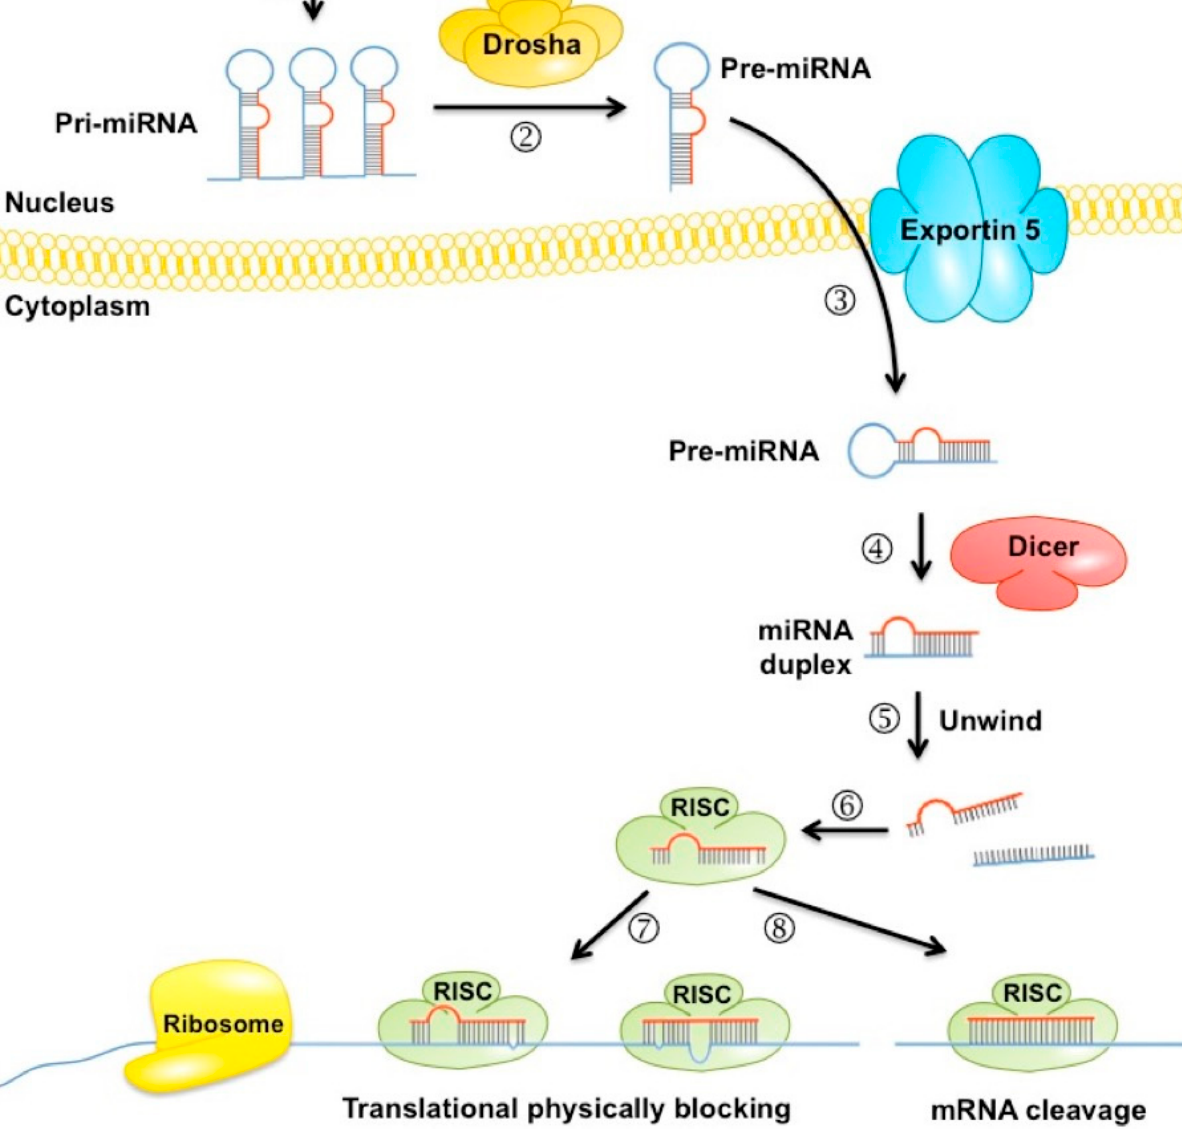
according to their miRNA-specific function. Moreover, miRNAs can predict diabetic complications such as cardiovascular diseases, chronic renal disease, or retinopathy. They display consistent and reproducible circulating levels, and are stable and resistant to RNase activity—essential characteristics in biomarker assessment. Previous studies concluded that diabetes-related miRNA does not change dramatically in the prediabetic stage [38]. Moreover, due to a wide range of prediabetic-associated miRNAs, choosing a set of representative prediabetic biomarkers is challenging [92–94].